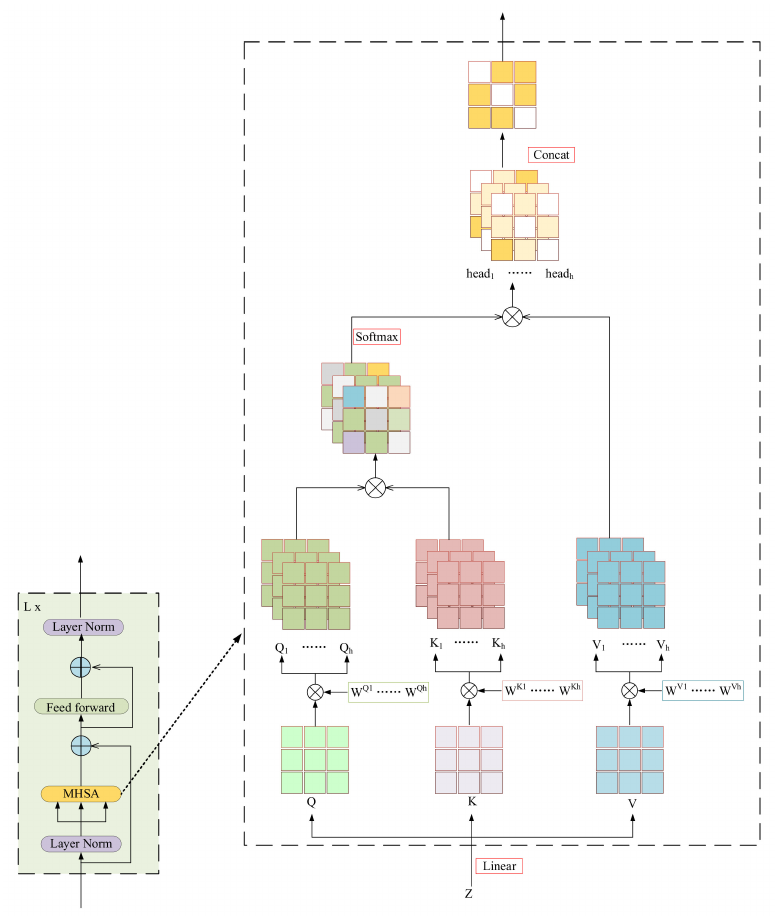
Figure 3. The second part of the ViT-Cap model architecture: transformer encoder